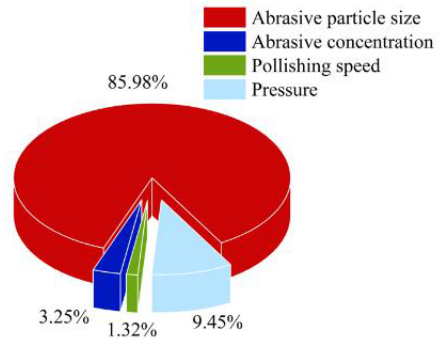
Figure 8. ANOVA results for R a .